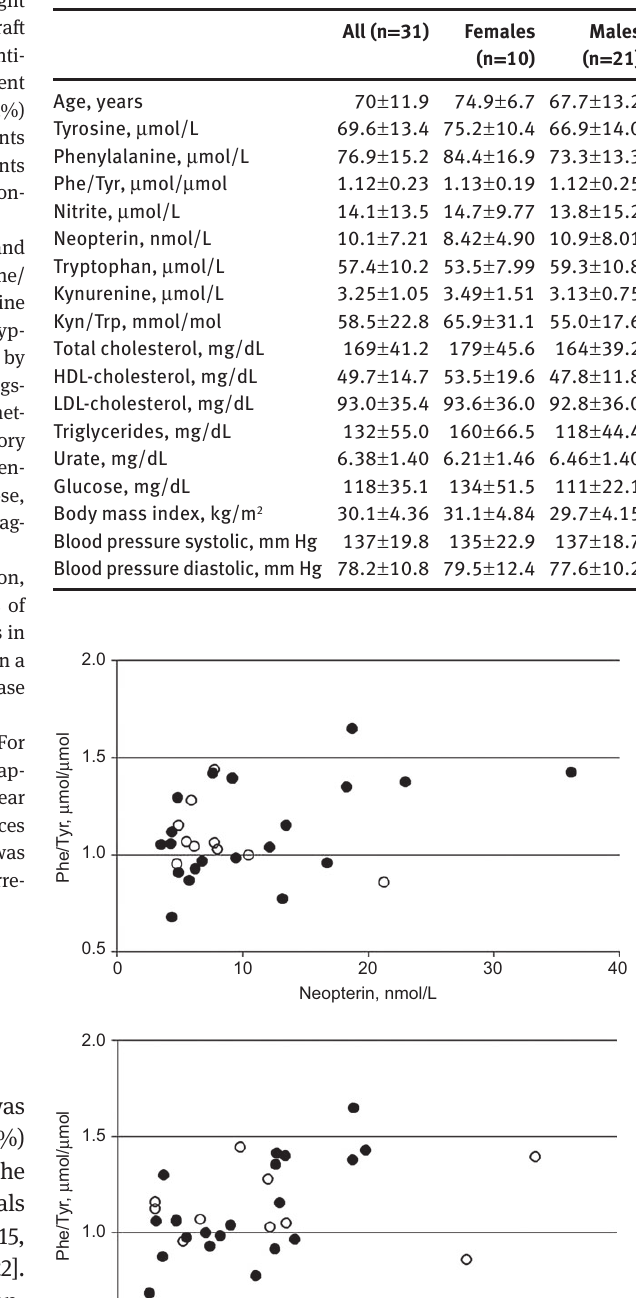
Table 1 Results of laboratory measurements in 31 patients suffering from cardiovascular disease and split into two groups by gender (mean values ± SD are shown; all differences between males and females are non-significant).